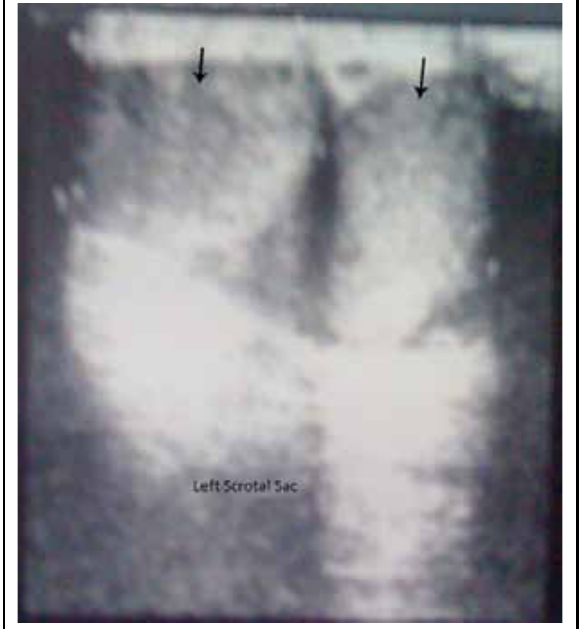
Figure 1. Ultrasonography image showing two testis located in left hemiscrotum.